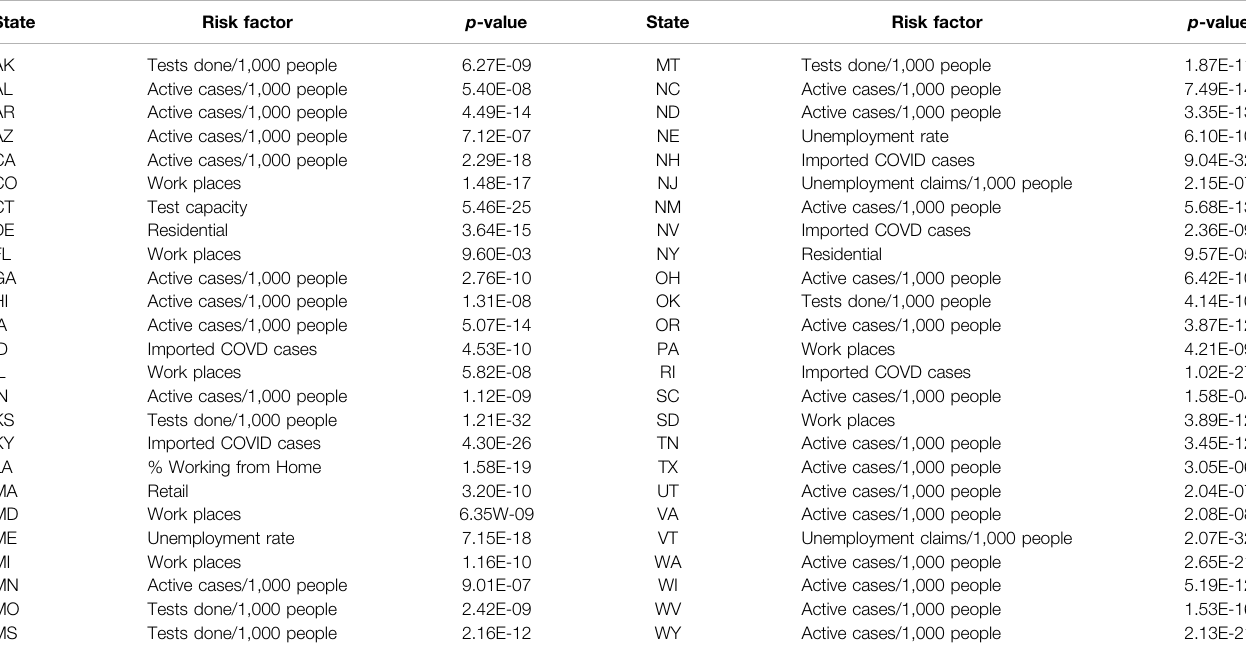
TABLE 4 | The most signi fi cant risk factor for the new cases of COVID-19 in each of 50 states in the